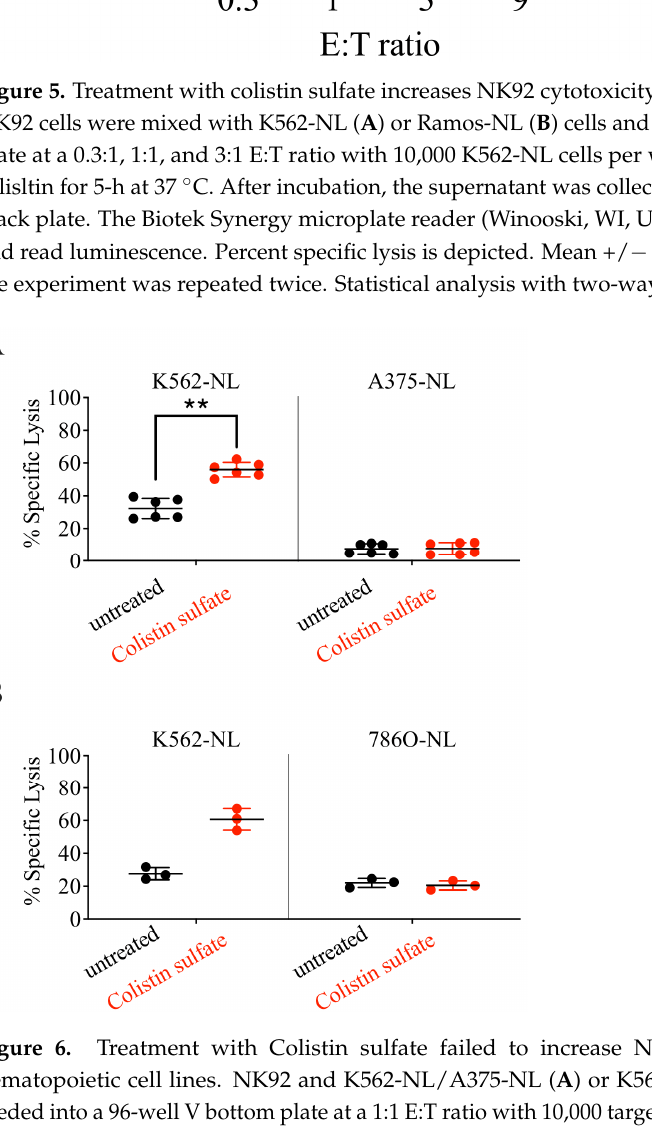
Figure 7. Treatment with Colistin sulfate increased IFN- γ production of NK92 stimulated with 786O cells. NK92 cells were stimulated at a 1:1 ratio with K562, Ramos, 786O, or A375 cells in the presence or absence of 10 μ M of colistin for 5-h at 37 °C. After incubation, NK cells were stained for CD107a